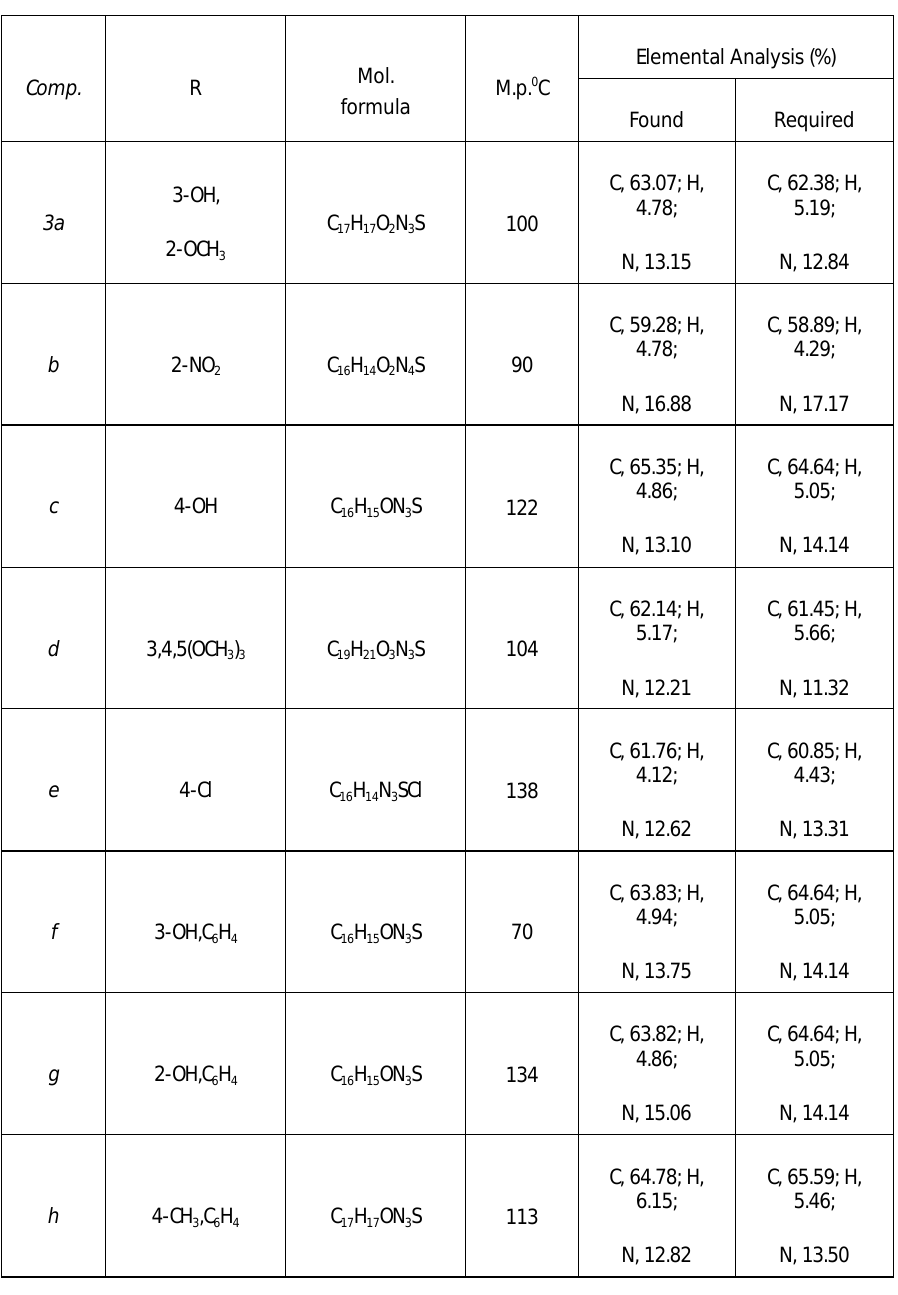
TABLE 1TABLE 1.. Physical data for compound [3a-h]